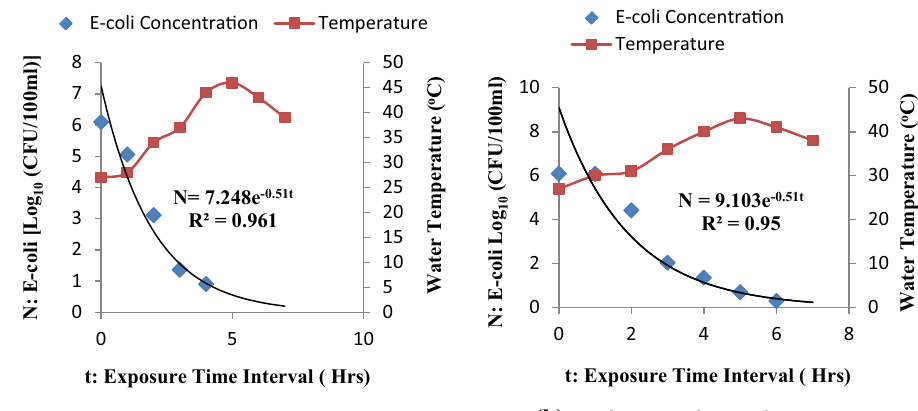
Fig. 11 a and b Day 4: Side- By-Side Performance Curves of the Improved SODIS and the Conventional SODIS